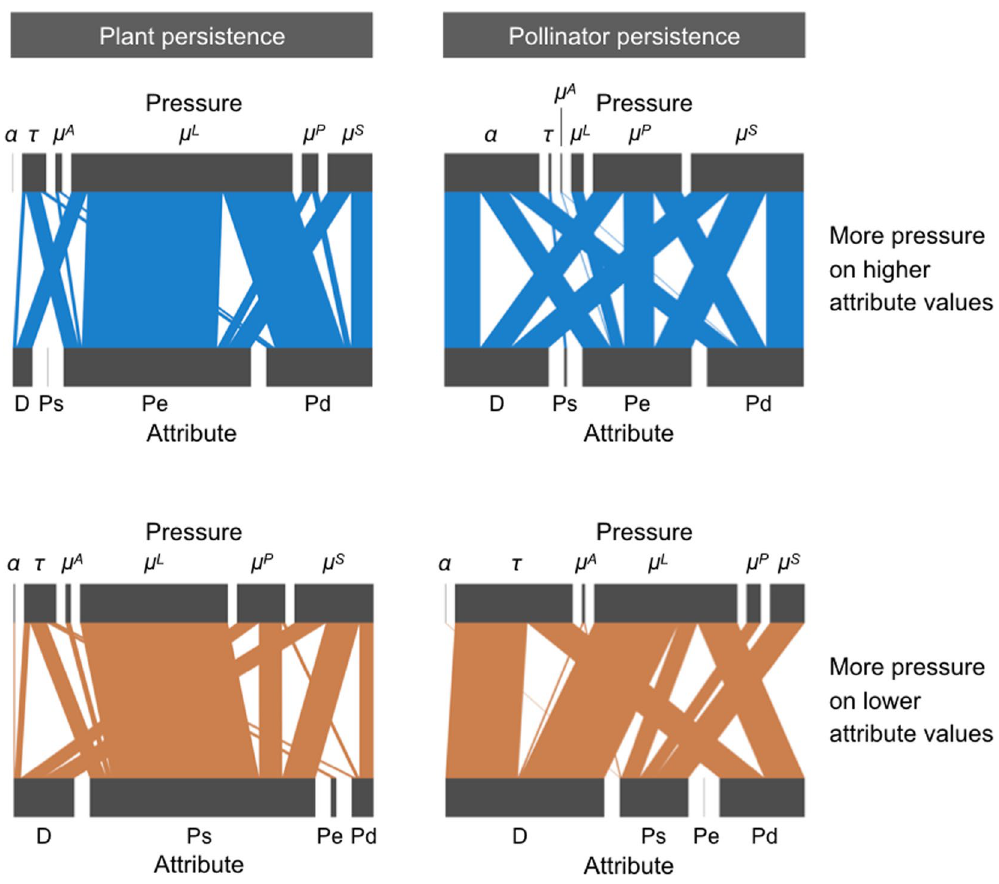
Figure 3. Summary of simulation results for all studied plant–pollinator networks described in Table 1. The webs summarize the adverse effects of different pressures (top blocks) exerted on species parameters (bottom blocks), according to values of species attributes. The width of the links are proportional to the corrected impact (see Methods, only positive values are shown). Perturbed parameters were plant competition intensity ( α ), pollinator visitation rate ( τ ), and mortality of adult pollinators, pollinator larvae, adult plants and seeds ( μ A , μ L , μ P , μ S respectively). Species attributes considered were degree (D), phenophase start (Ps), phenophase end (Pe) and phenophase duration (Pd). In top (blue) diagrams, pressure magnitude increased on species of increasing attribute values (e.g. low to high D, earlier to later Ps or Pe, and small to large Pd). In bottom (red) diagrams, pressure magnitude increased on species of decreasing attribute values. Left and right webs show respectively the resulting effects on plant and pollinator species